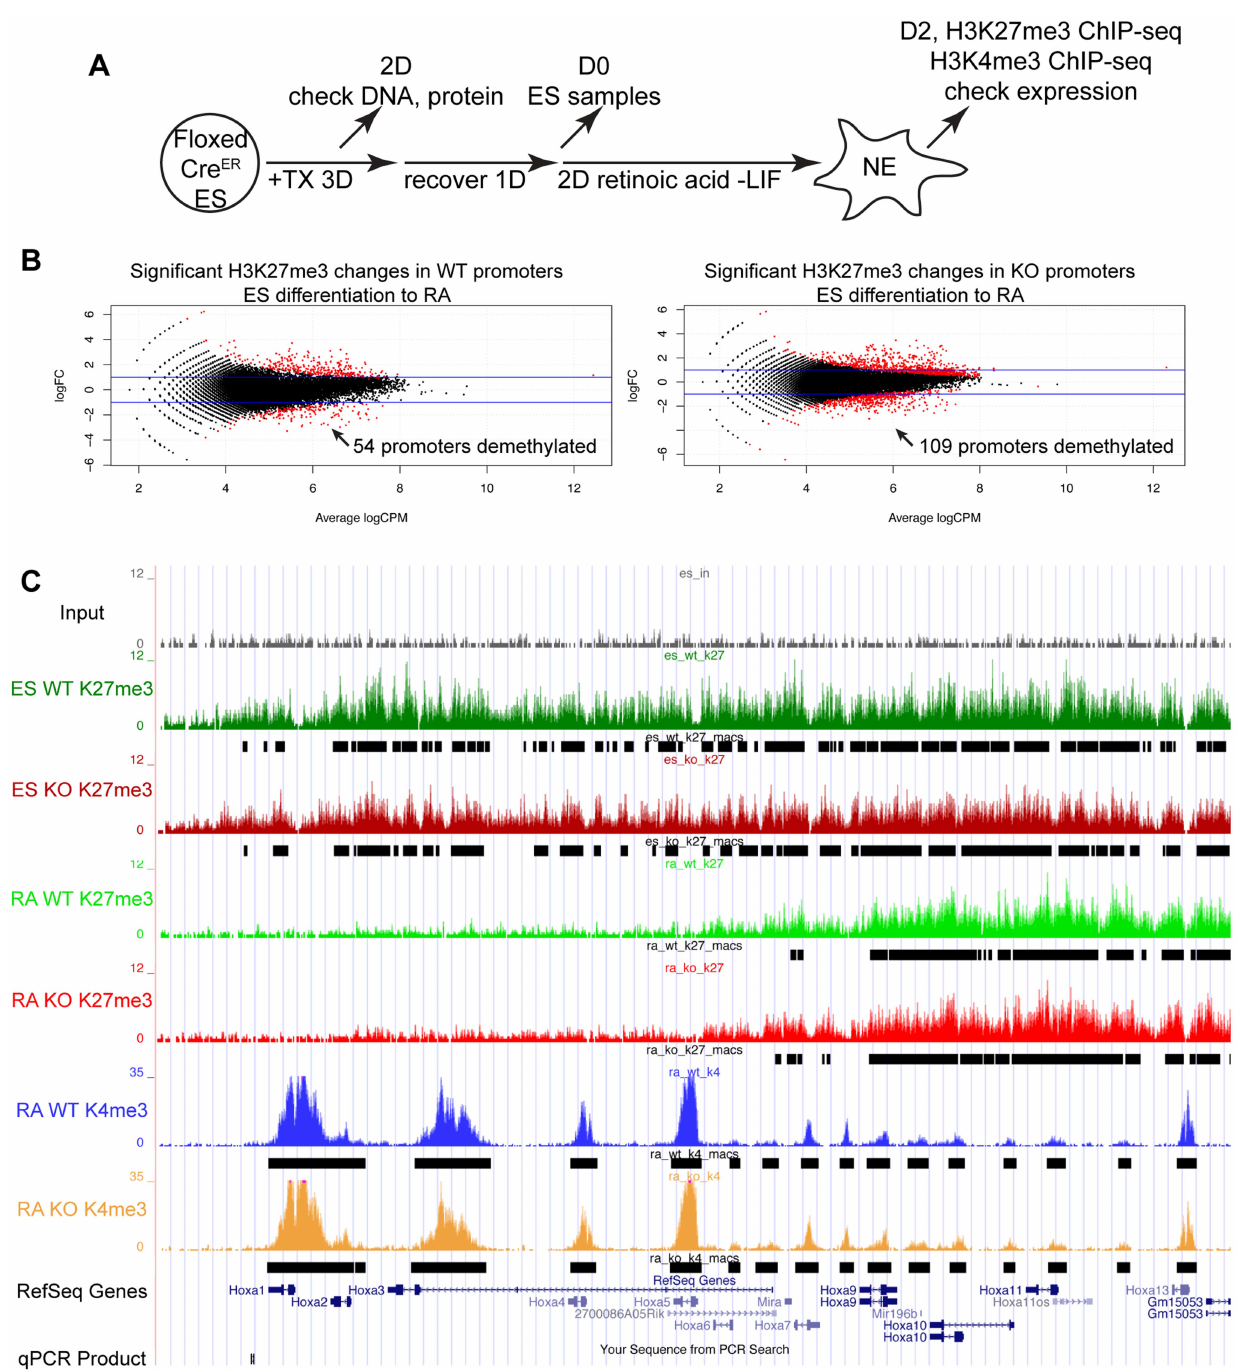
Figure 3. Proximal Hox genes demonstrate loss of H3K27me3 with RA treatment in the absence of KDM6 demethylation. (A) Utx fl/fl ; Jmjd3 fl/fl ; Cre ER ES cells were untreated (WT) or pre-treated with TX for 3 days (KO), recovered, and differentiated to neuro-ectoderm with 2 days of retinoic acid treatment. H3K27me3 and H3K4me3 ChIP-seq were performed on D0 ES cells and D2 RA treated cells. (B) The normalized sequence reads from all promoters ( + / 2 1 KB) from ES and RA treated cells were compared by edgeR to identify promoters that exhibit H3K27me3 reductions in either WT ( Utx fl/fl ; Jmjd3 fl/fl ; Cre ER 2 TX) or KO ( Utx fl/fl ; Jmjd3 fl/fl ; Cre ER + TX) cells. The log fold change (logFC) is plotted against the average log counts per million reads (Average logCPM). In the plot, 54 WT and 109 KO promoters exhibited H3K27me3 reductions with RA treatment (negative logFC, FDR , 0.05, and an identified H3K27me3 MACS peak in ES cells). (C) UCSC genome browser view of ChIP-seq tracks for the Hoxa cluster. Illustrated are Input (black), WT ES H3K27me3 ChIP (dark green), KO ES H3K27me3 ChIP (dark red), WT RA H3K27me3 ChIP (light green), KO RA H3K27me3 ChIP (light red), WT RA H3K4me3 ChIP (blue), KO RA H3K4me3 ChIP (orange), and MACS defined enrichment peaks are illustrated as black bars underneath each track. The RARE region tested by ChIP-qPCR is noted on the bottom.